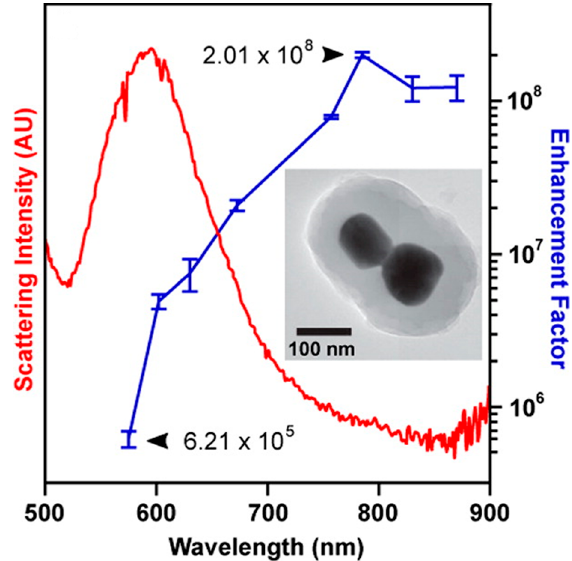
Figure 17. Scattering intensity (red line) and enhancement factor (blue points) measured for the single gold nanoparticle dimer embedded in a silica shell shown in the inset. Reproduced with permission from Kleinman et al. [26]. Copyright (2013), American Chemical Society.